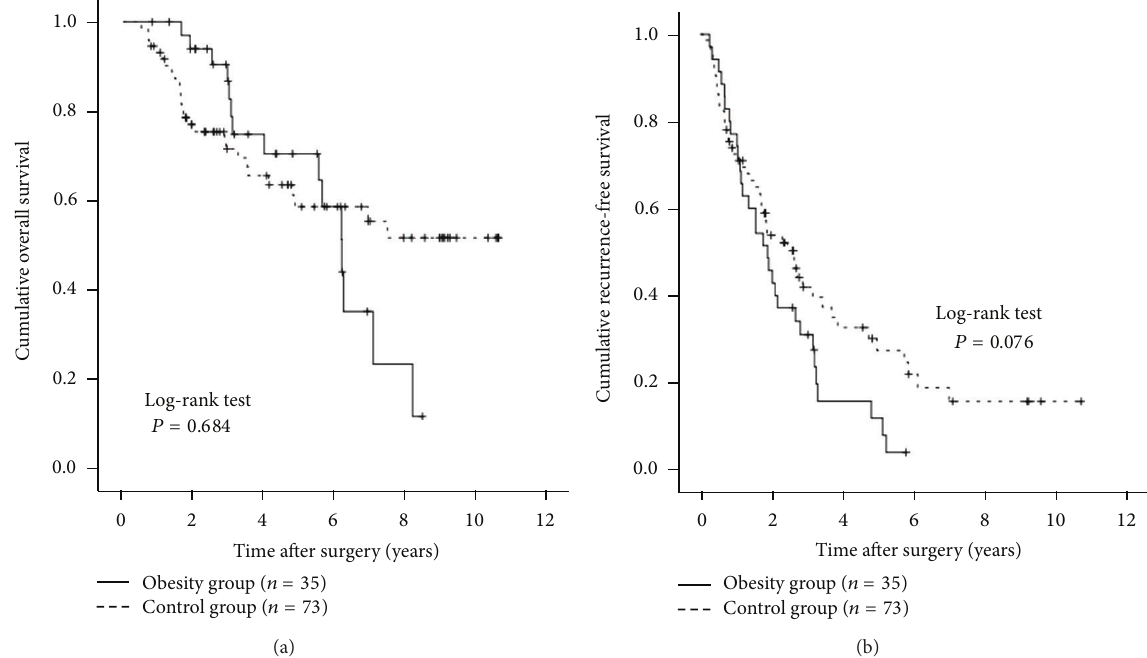
Figure 5: Subgroup analyses in patients aged less than 70 years ( 𝑛 = 108 ). There were 35 patients aged younger than 70 years in the obesity group and 73 in the control group. There were no differences between the two groups in terms of OS (a) ( 𝑃 = 0.684 ). However, the RFS rates in the obesity group tended to be lower than those in the control group, although the difference did not reach significance (b) ( 𝑃 = 0.076